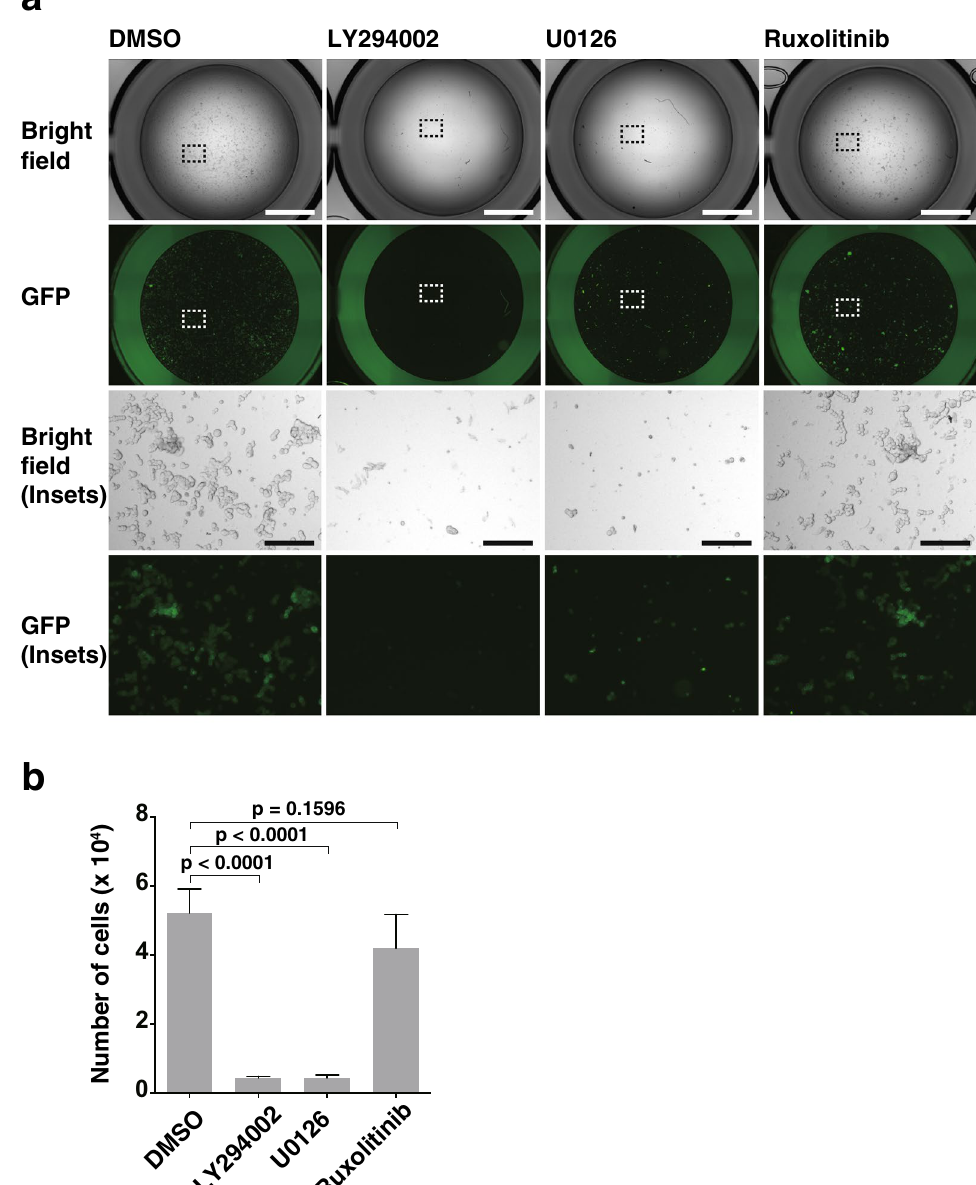
Figure 2. PI3K-AKT signaling- and the Ras-Raf-MEK-ERK signaling-dependent, but not the JAK-STAT signaling-dependent, enhancement of T47D cell proliferation by nectin-4 and p95-ErbB2 in a suspension culture. ( a , b ) The PI3K-AKT signaling- and the Ras-Raf-MEK-ERK signaling-dependent, but not the JAK- STAT signaling-dependent, enhancement of T47D cell proliferation by nectin-4 and p95-ErbB2 in a suspension culture. The T47D cells stably expressing GFP-tagged p95-ErbB2 (p95-ErbB2-GFP) with FLAG-tagged nectin-4 (FLAG-Nectin-4) were detached using Accutase. The cells were collected, their numbers were counted, and the same numbers of the cells were seeded in the serum-free medium with supplements on ultra-low attachment 6 well dish. After the incubation with the PI3K inhibitor LY294002 at 50 μM, the MEK inhibitor U0126 at 10 μM, or the JAK1/2 inhibitor ruxolitinib at 1 μM for 28 days, the cells were collected and transferred to ultra-low attachment 96 well dish for image acquisition. Then, the cells were re-collected and subjected to quantitative analysis by cell counting as shown in ( b ). The displayed images were acquired using a BZ-X710 microscope and its software BZ-X Analyzer (https:// www. keyen ce. co. jp/ produ cts/ micro scope/ fluor escen ce- micro scope/ bz- x700/ models/ bz- x710/) with BZ-H3A Advanced Application software (https:// www. keyen ce. co. jp/ produ cts/ micro scope/ fluor escen ce- micro scope/ bz- x700/ models/ bz- h3a/) for image connection. The T47D cells stably expressing p95-ErbB2-GFP with FLAG-Nectin-4 used in the experiments were the bulk of collected cells and not singly picked-up clones. Bars indicate the means ± S.D. of three independent experiments and the actual P values for each test are shown. Scale bars 2000 μm or 200 μm (insets). Representative results (images) from three independent experiments were